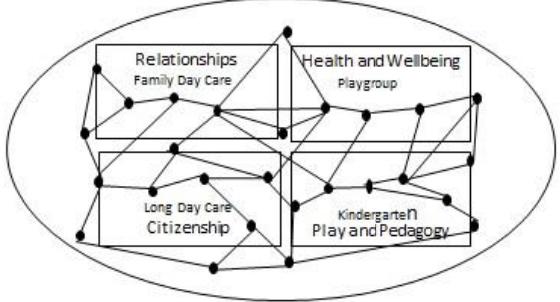
Figure 2. Field of action intelligibility.